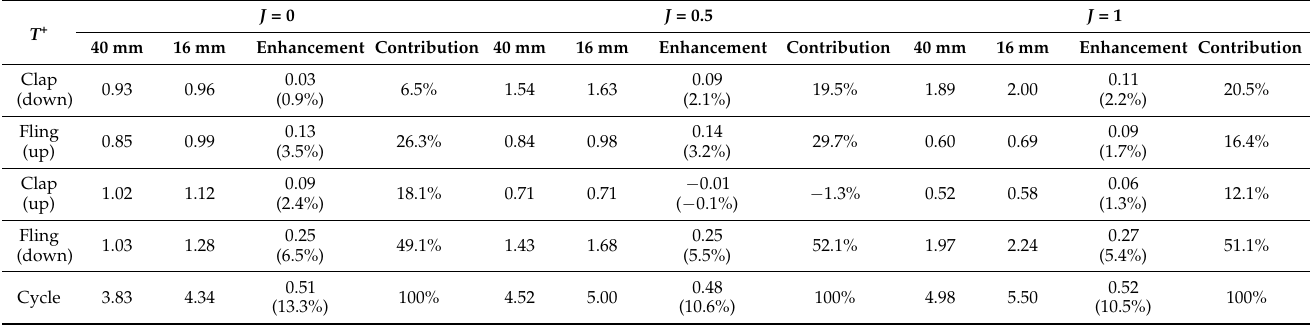
Table 3. Contribution of clap and fling phases to the mean torque enhancement.